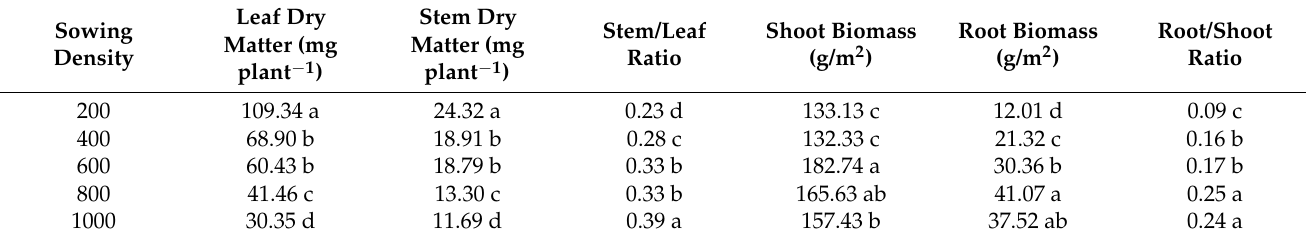
Table 2. The effect of sowing density on dry matter and